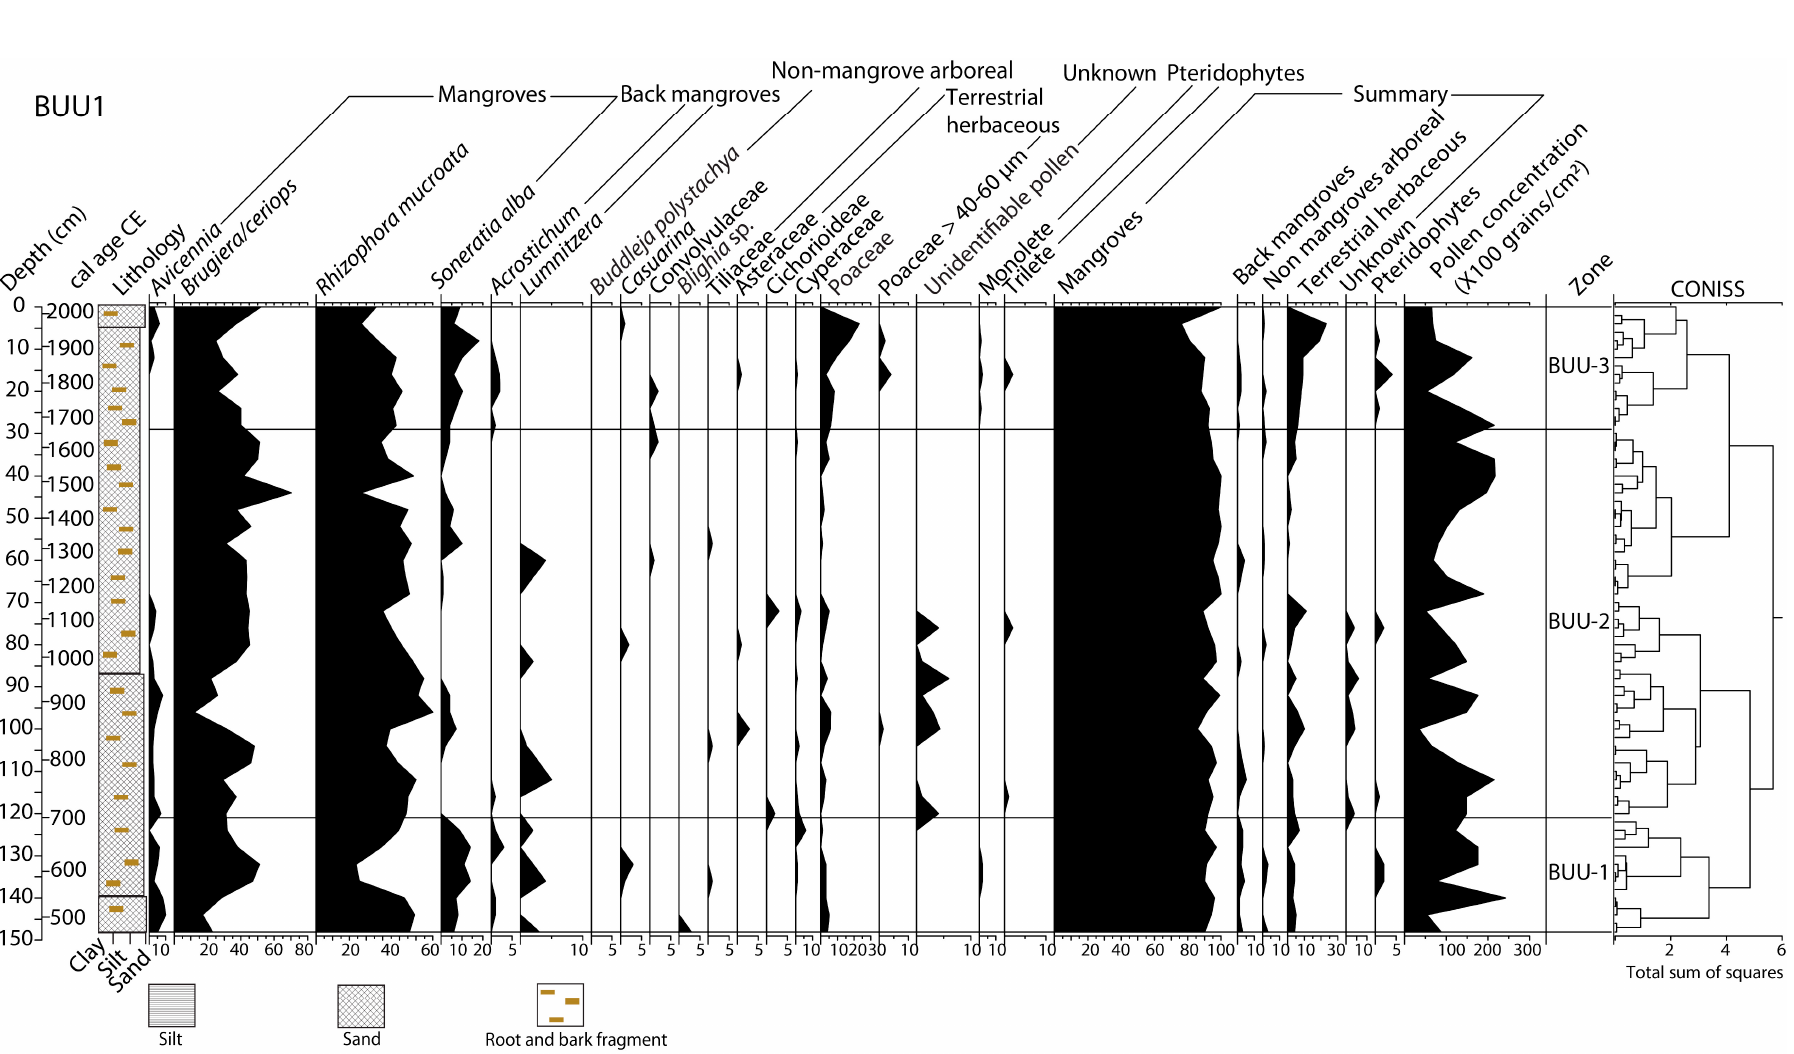
Figure 5. Pollen percentage diagram of BUU1 core.